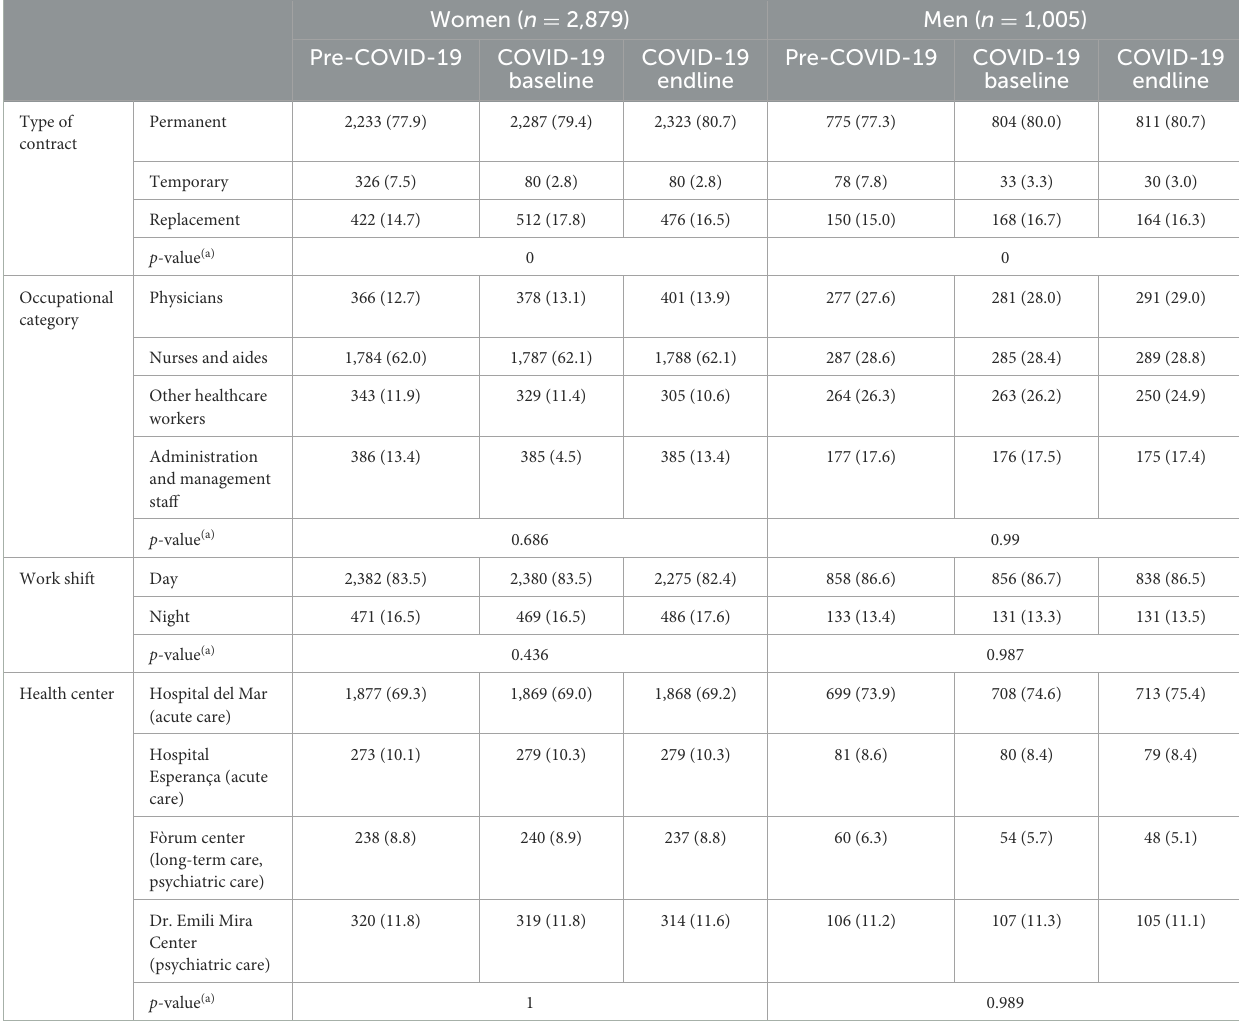
TABLE 2 Healthcare workers occupational variables ( n , %) by time period ∗ and